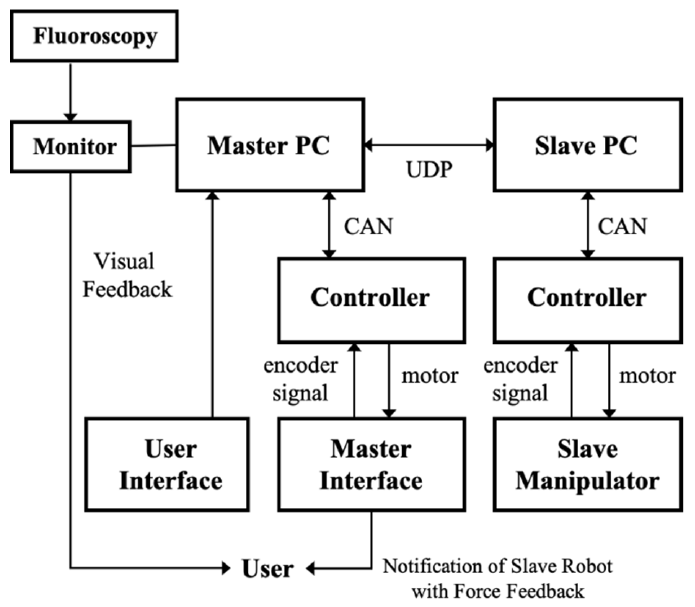
Figure 6. Communication diagram of the master–slave system.